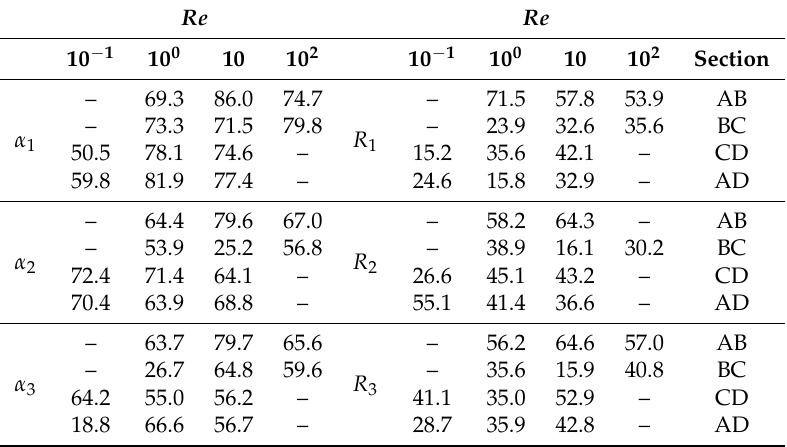
Table 5. Percentage error (%) between experimental and analytical data for pressure taps with sub-channel width w 3 = 162 µ